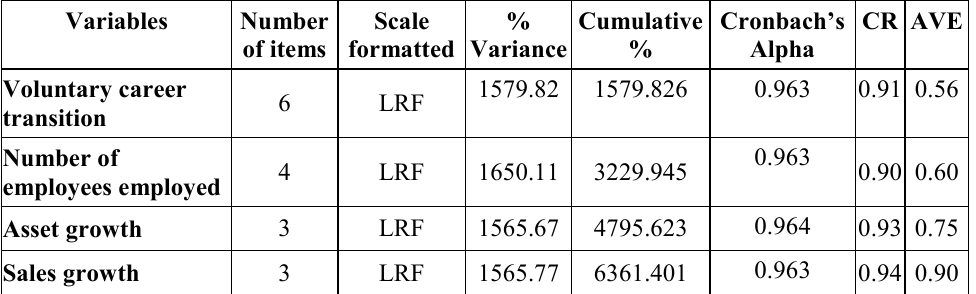
The Table 1 shows the reliability and validity